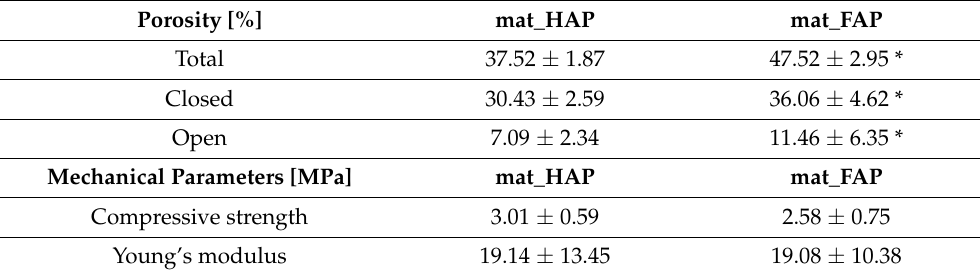
Table 1. Evaluation of porosity and mechanical properties of fabricated